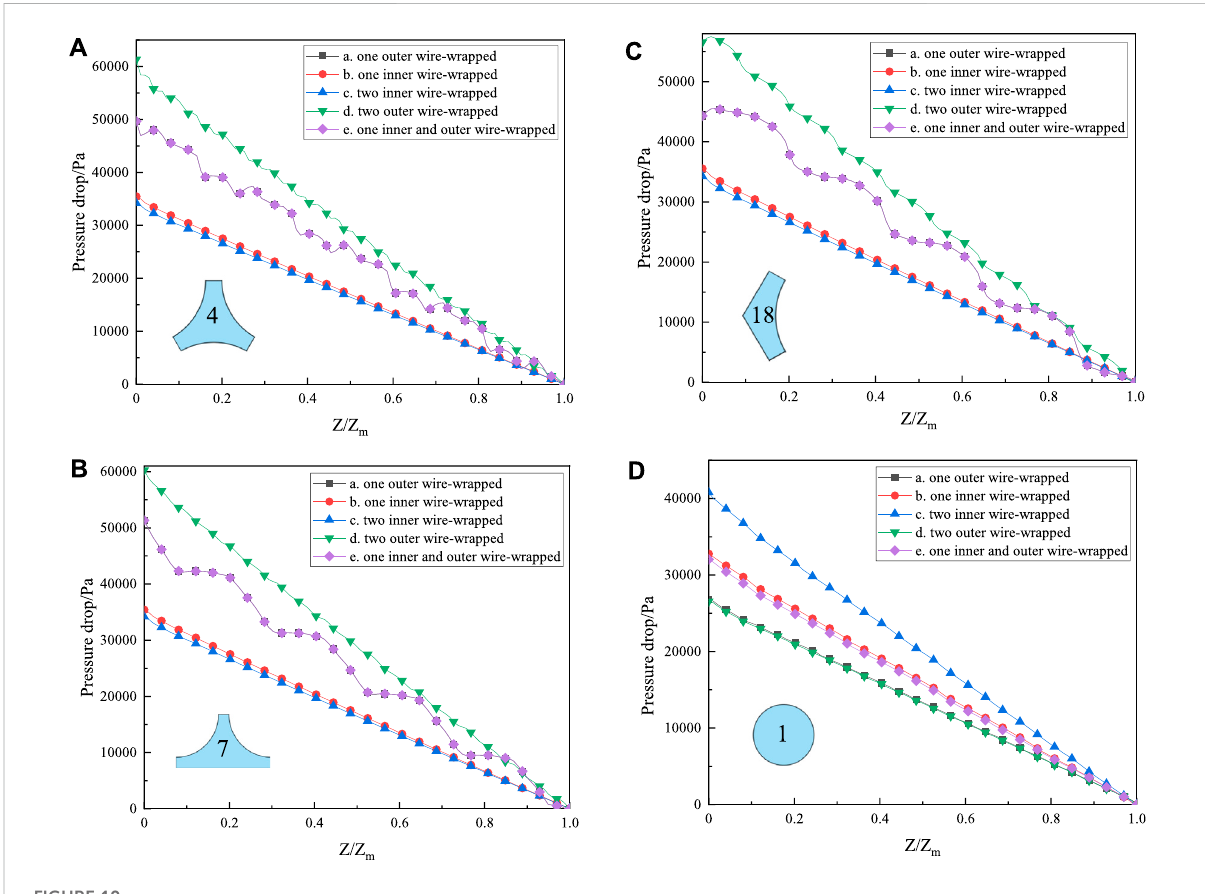
FIGURE 10 Distribution of pressure drop in the (A) interior sub-channel, (B) edge sub-channel, (C) corner sub-channel, and (D) inner fl ow fi